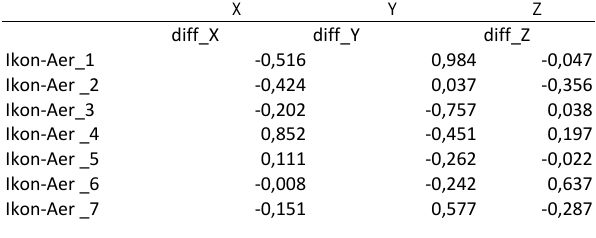
Table 2 Differences in Control points with